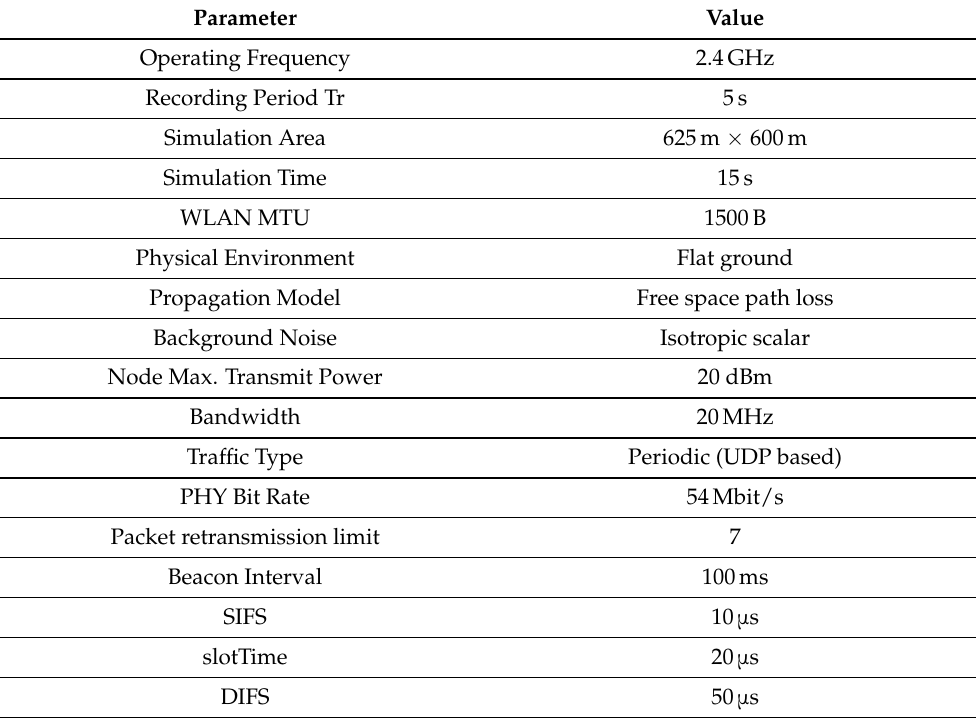
Table 3. Simulation Parameters.